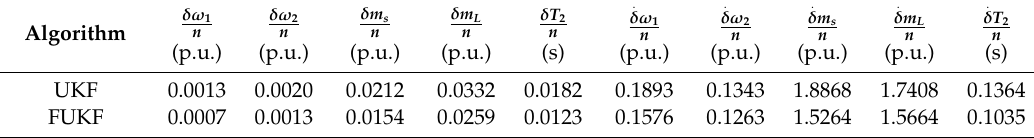
Table 2. Values of the estimation errors and their derivatives for the UKF and FUKF—simulation study.